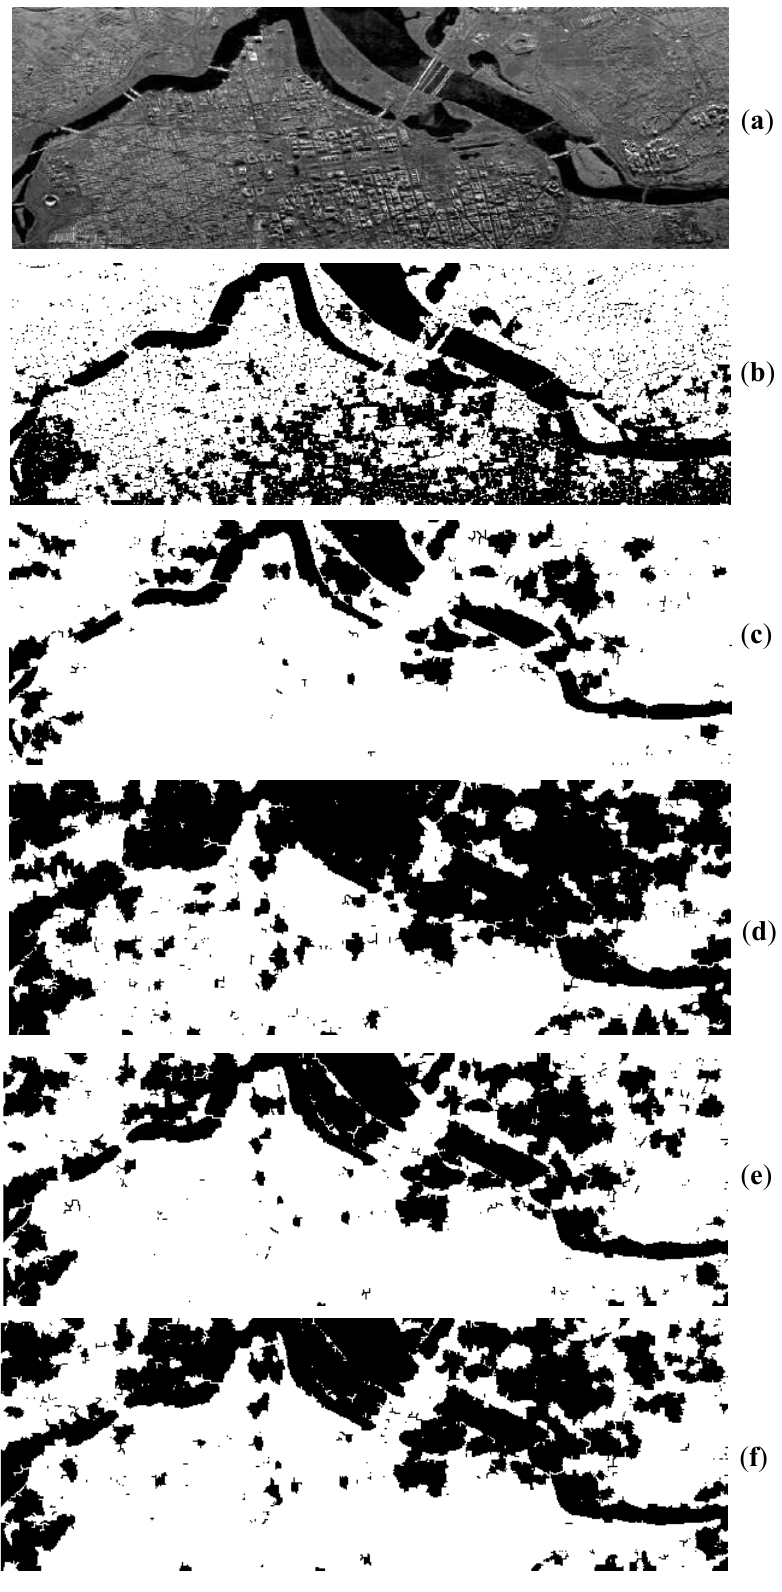
Figure 17. Segmentation results on SAR8. ( a ) original image; ( b ) AFWDLMO; ( c ) AFCMOMA; ( d ) AFCMDE; ( e ) MoMODEFC; ( f )